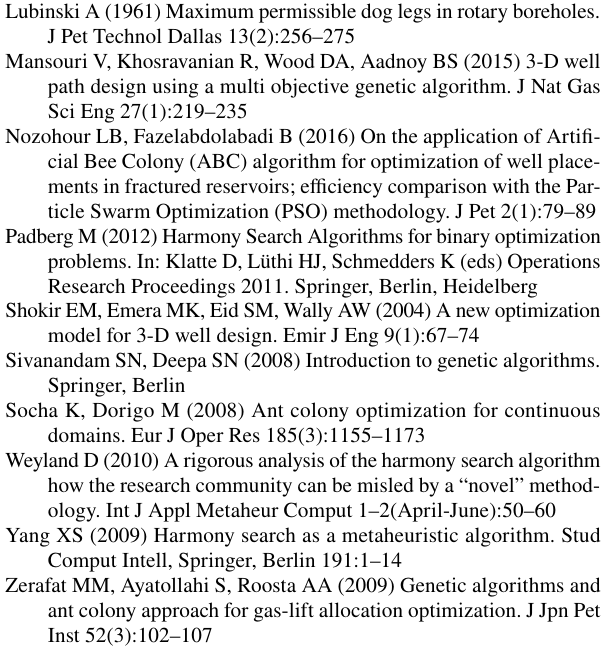
algorithm. J Nat Gas Sci Eng 28:347–355 Guria C, Goli KK, Pathak AK (2014) Multi-objective